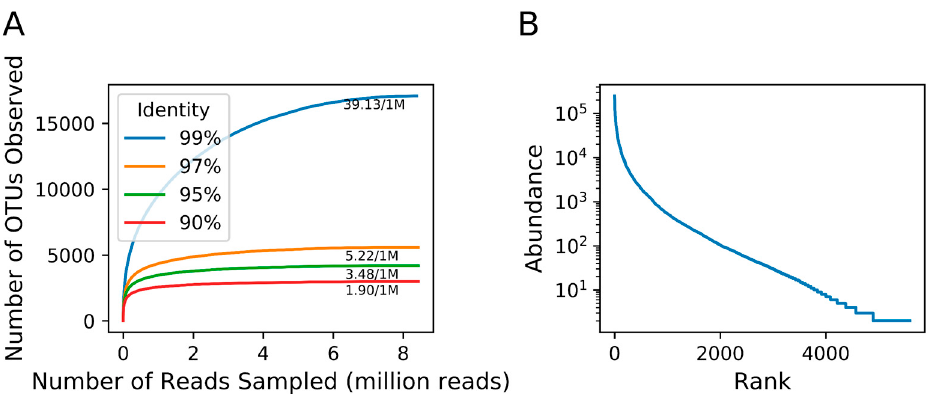
Figure 4. Megaviridae operational taxonomic units (out) richness. ( A ) Rarefaction curves for Megaviridae polB OTUs with various DNA sequence identity cutoffs. Proximity to saturation is indicated by weak slopes at the end of each rarefaction curve. For instance, an increase in 39.13 OTUs per resampling of one million reads is noted as 39.13/1M. ( B ) Rank abundance curve of Megaviridae polB OTUs at 97% DNA sequence identity. Y -axis represents the number of reads supporting individual OTUs.